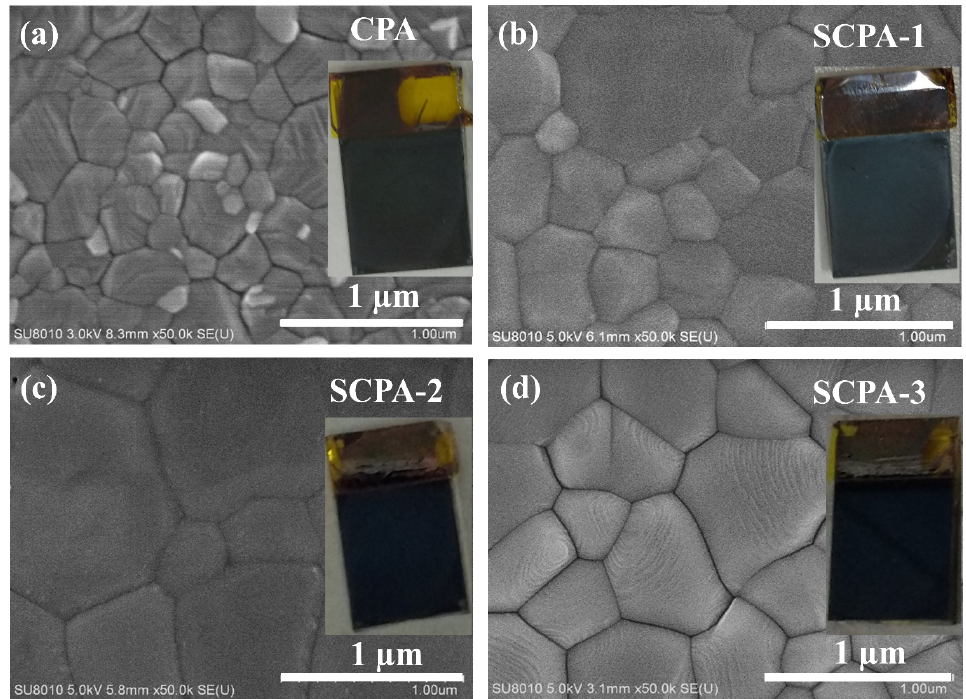
Figure 2. SEM images of the as-prepared perovskite thin-films with CPA ( a ) and SCPA ( b – d ). Insets are the digital photos of each perovskite/SnO 2 /FTO-substrate.